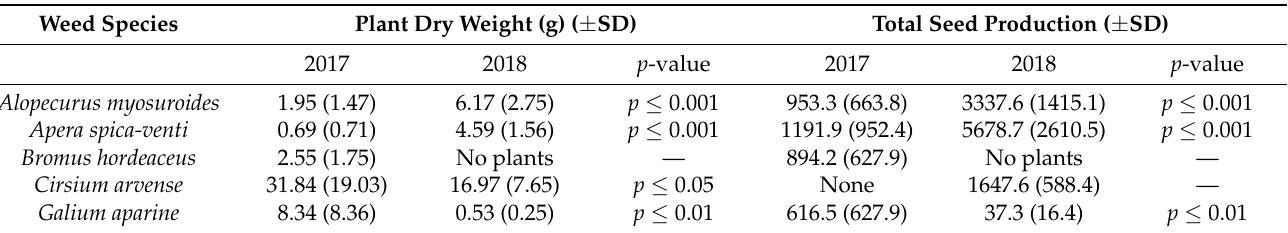
Table 2. Average plant dry weight (g) with standard deviation (SD) and total seed production of weed species in wheat fields in 2017 and 2018. p -values shown for difference between the